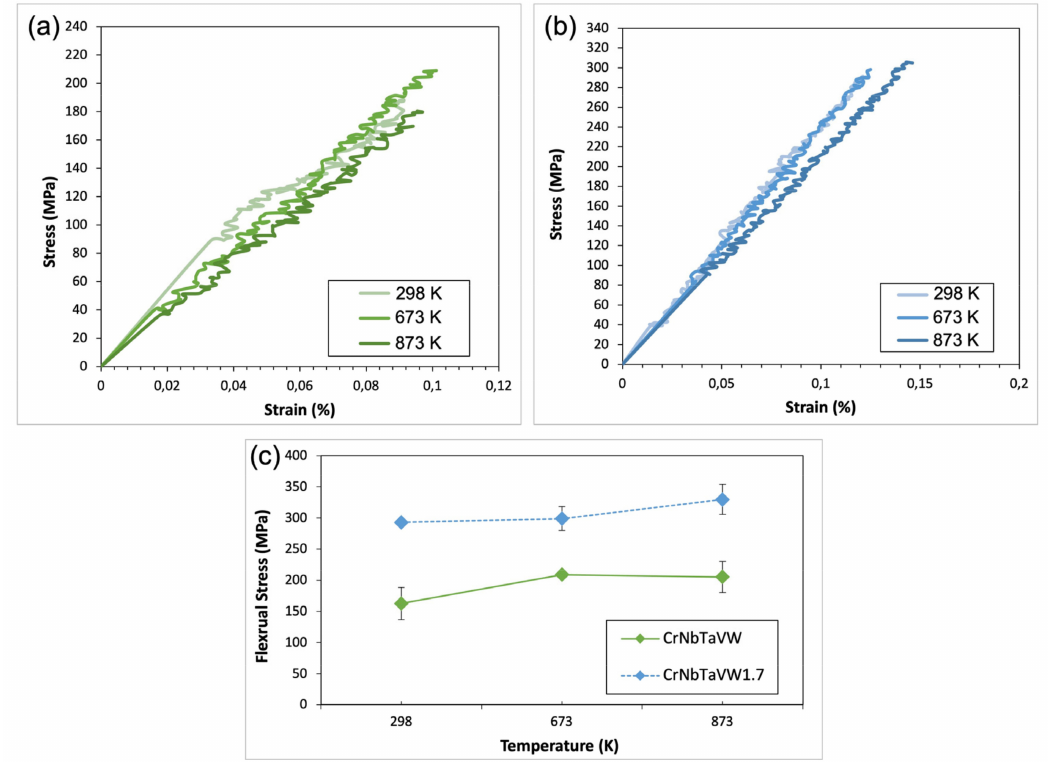
Figure 4. Stress-strain curves for ( a ) CrNbTaVW and ( b ) CrNbTaVW 1.7 and ( c ) flexural strength- fracture strain of both samples at 298 K, 673 K and 873 K.